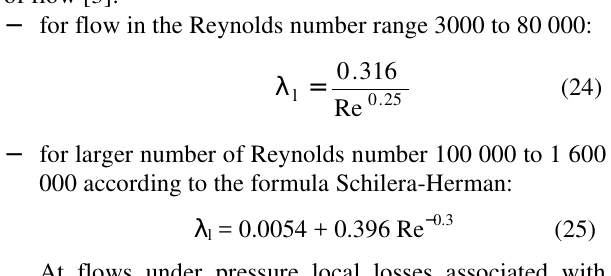
or from the empirical model